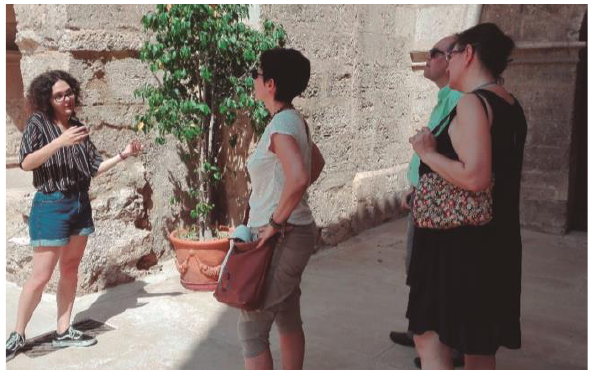
Figure 1. Public visit to San Juan del Hospital in